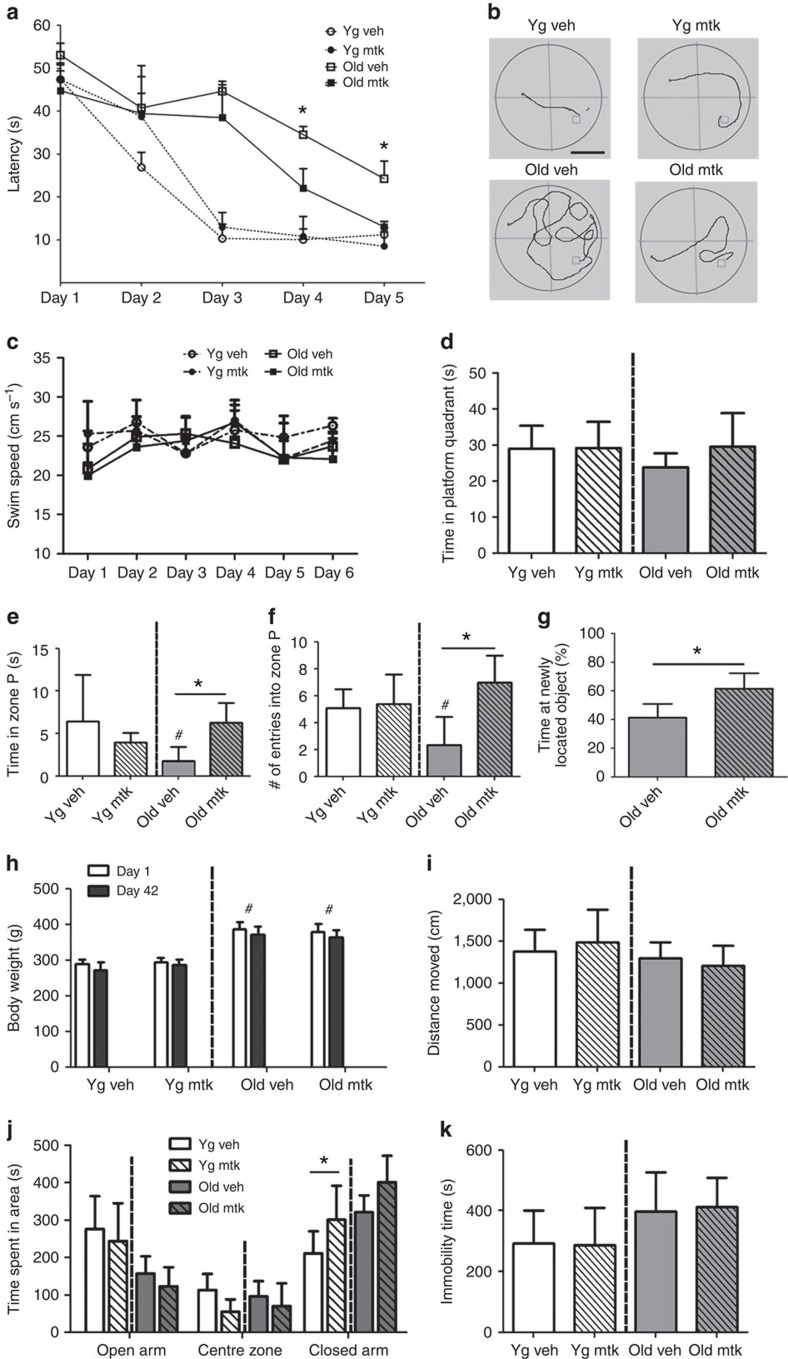
Montelukast treatment improves learning and memory in old rats.(a) Latency times to find the hidden platform in the Morris water maze test after daily oral administration of 10 mg kg−1 montelukast for 6 weeks. (b) Representative tracks of the distances moved in the Morris water maze on day 4 in the different age and treatment groups (scale bar, 50 cm). (c) Swimming speeds of animals in the Morris water maze test. (d–f) Results of probe trial on day 6: (d) time spent in the former platform quadrant; (e) time spent in zone P, a defined circular area of 20 cm diameter that encloses the former platform location; (f) number of entries into zone P. (g) Results of the object location memory test (performed on an additional cohort of rats). (h) Body weight of the animals on days 1 and 42 of treatment. (i) Locomotion as assessed by the distance moved in the open field. (j) Anxiety assessed in the elevated plus maze with analysis of time spent in the closed, centre and open arms. (k) Depression-like behaviour (immobility time in the forced swim test). Data are shown as mean±s.e.m. (a, c) or mean±s.d. (d–k). * indicates P<0.05; # indicates significant differences (P<0.05) compared to young vehicle. Two-way ANOVA (a,c,h,j), One-way ANOVA (d–f,i,k) with Bonferroni post hoc tests, and the unpaired Student's t-test (g) were performed. N per group (a–f; h–k): 10 (young vehicle), 10 (young montelukast), 7 (old vehicle), 7 (old montelukast); (g): 5 (old vehicle), 5 (old montelukast). yg veh, young vehicle; yg mtk, young montelukast; old veh, old vehicle; old mtk, old montelukast.